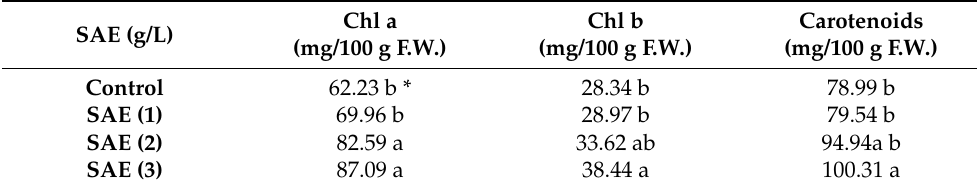
Table 7. Effects of Spirulina platensis aqueous extract (SAE) treatments on the chlorophyll a (chl a), b (chl b), and carotenoid contents of C. longa leaves.